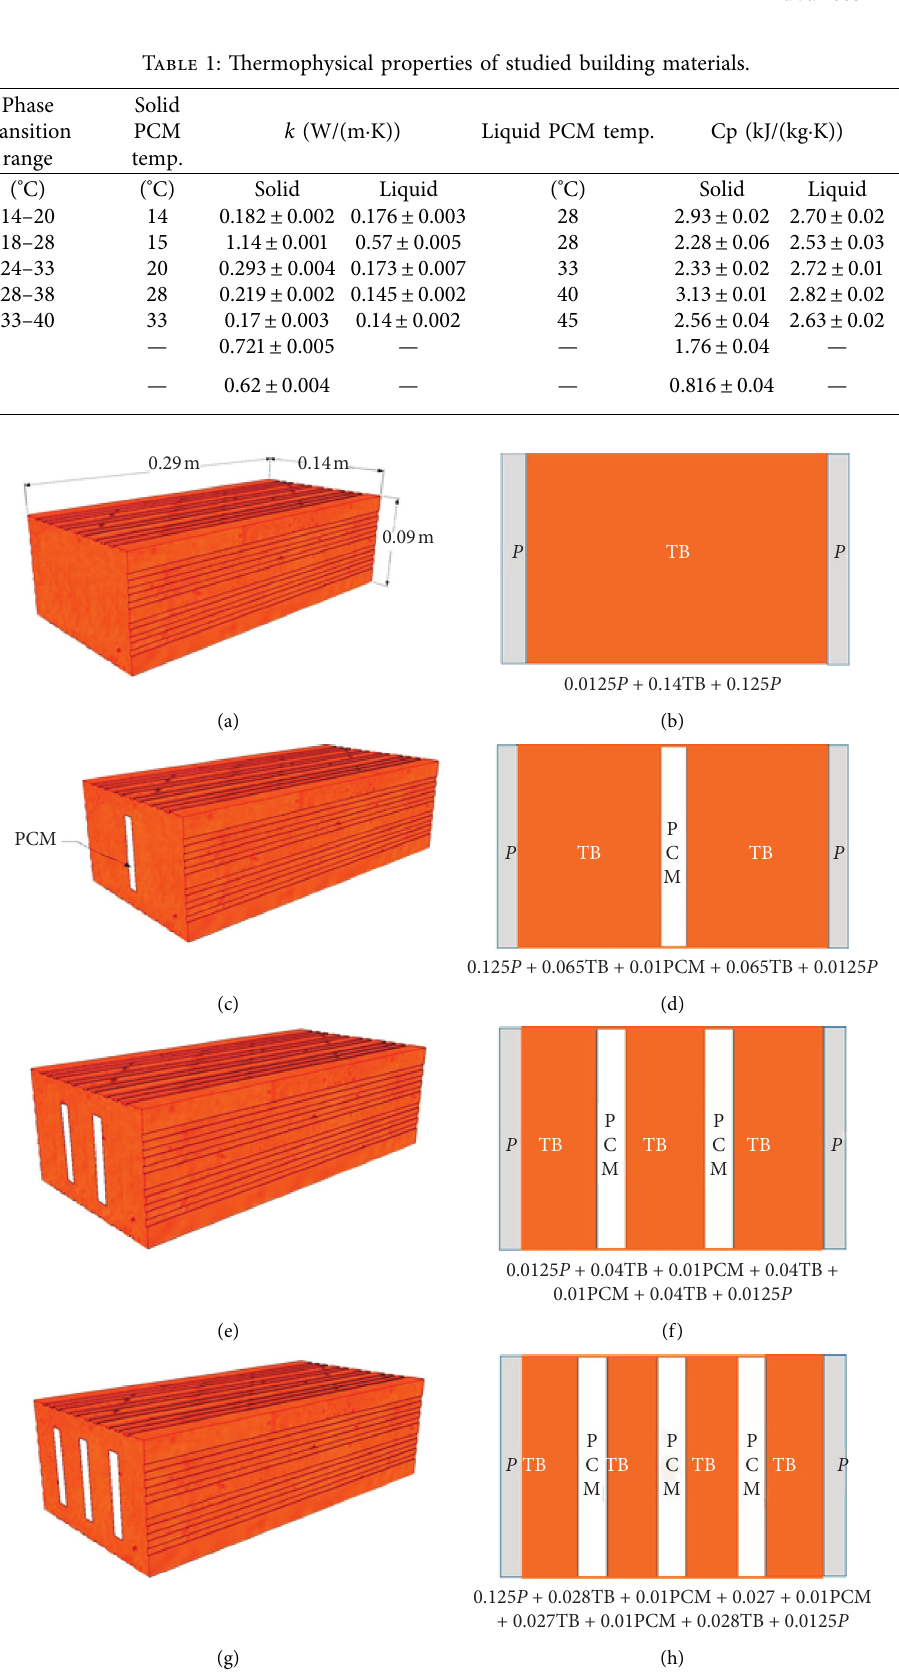
Figure 2: Outline of assumed terracotta brick geometries: (a)-(b) solid terracotta brick; (c)-(d) terracotta brick with one PCM layer; (e)-(f) terracotta brick with two PCM layers; (g)-(h) terracotta brick with three PCM